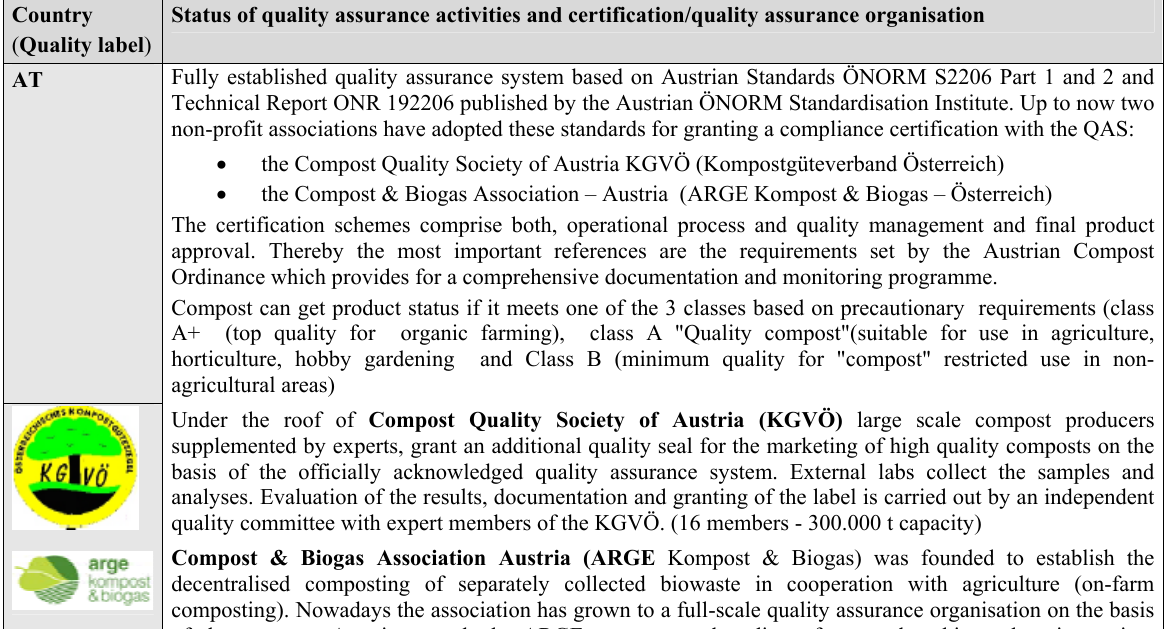
Table 23: Status of quality assurance schemes in EU Member